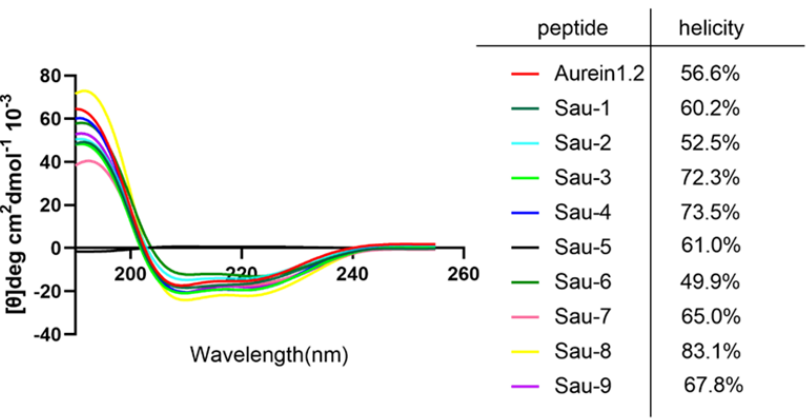
Figure 3. CD spectra of Aurein1.2 and its analogues. The peptides were dissolved in a solution of phosphate buffer and trifluoroethanol (7:3) and reached a concentration of 50 µ M. The helicities of these peptides were calculated on the [ θ ] 222 .